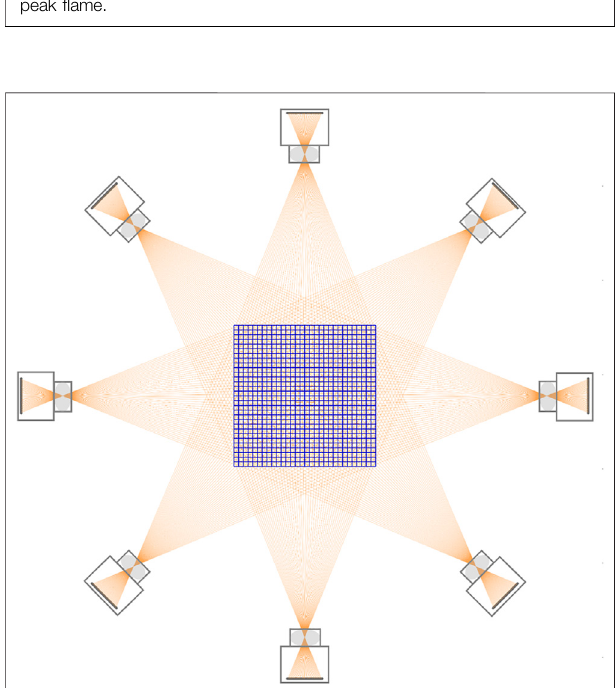
FIGURE 6 | The schematic diagram of the layout of the eight linear camera